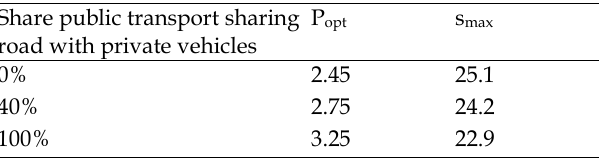
Table 3. Effects of share of road over total public transport demand on optimal price and